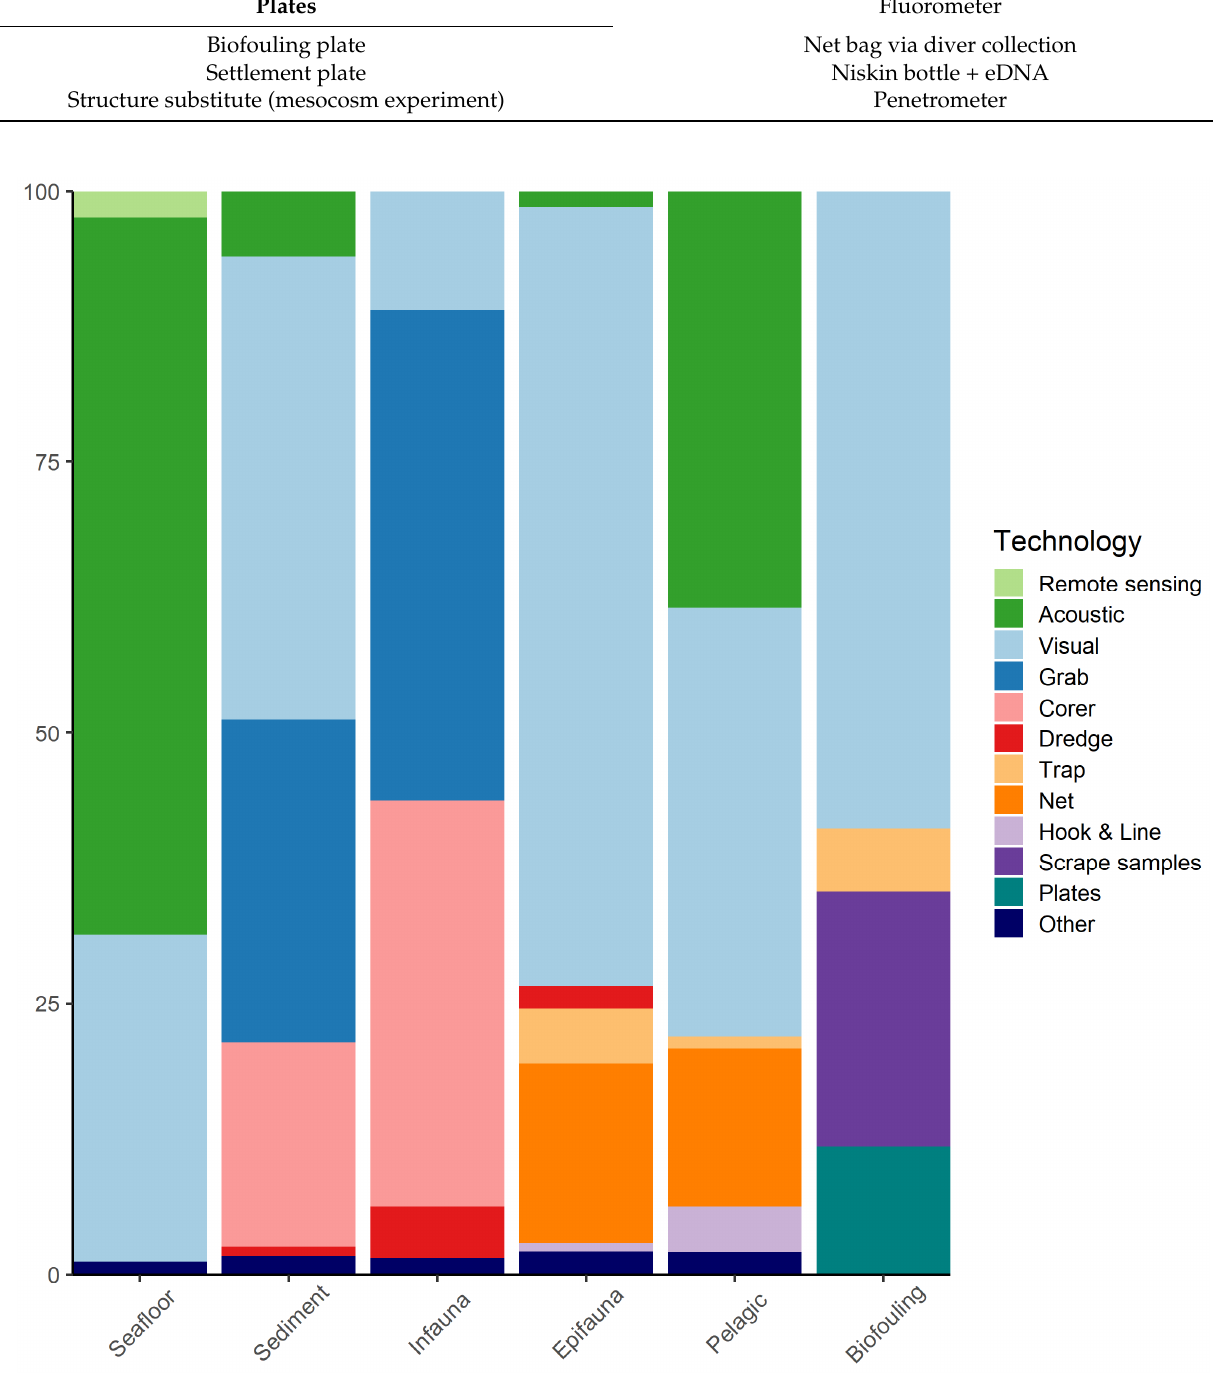
Figure 1. Proportions of the different technologies used for describing habitats and measuring changes in their characteristics.